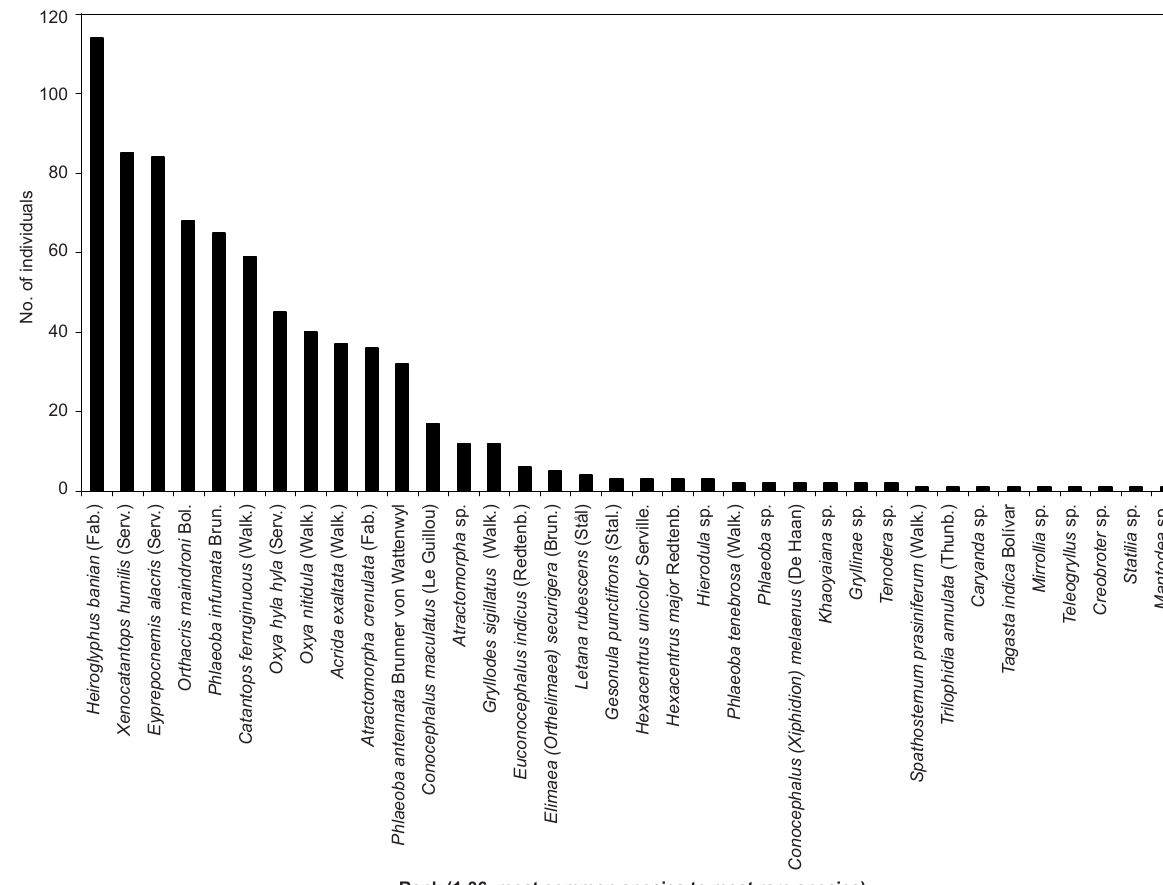
Rank (1-36, most common species to most rare species) Figure 3. Log series distribution pattern of orthopteroids in Kaziranga National Park, Assam